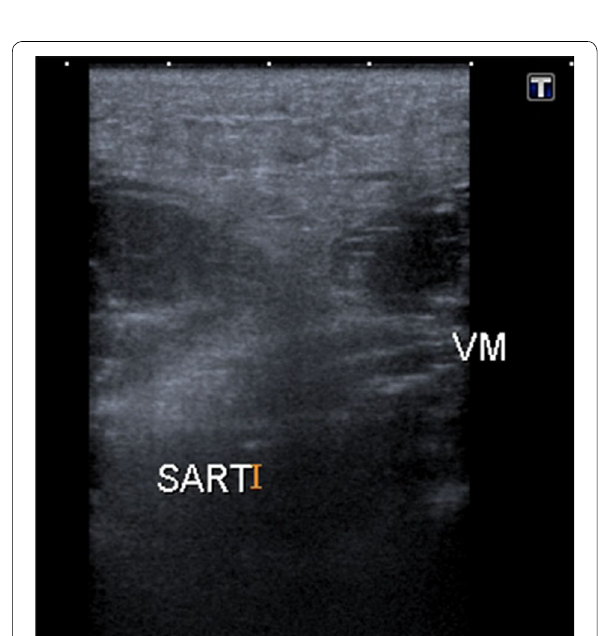
Fig. 2 Transverse ultrasound image of sartorius